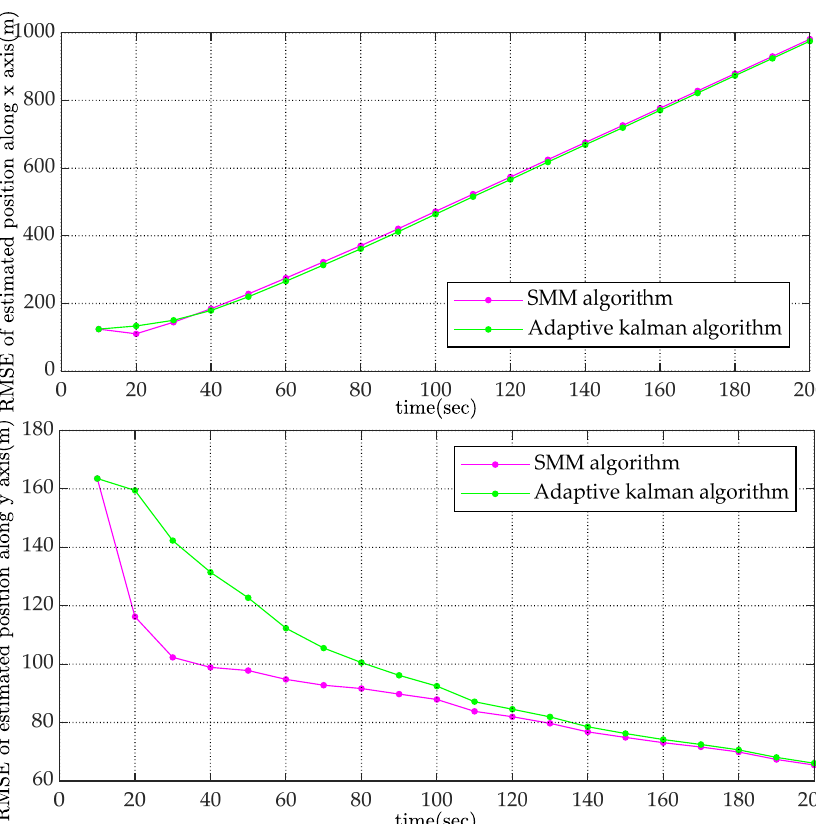
Figure 5. Comparison of RMSE for estimated velocity and course.